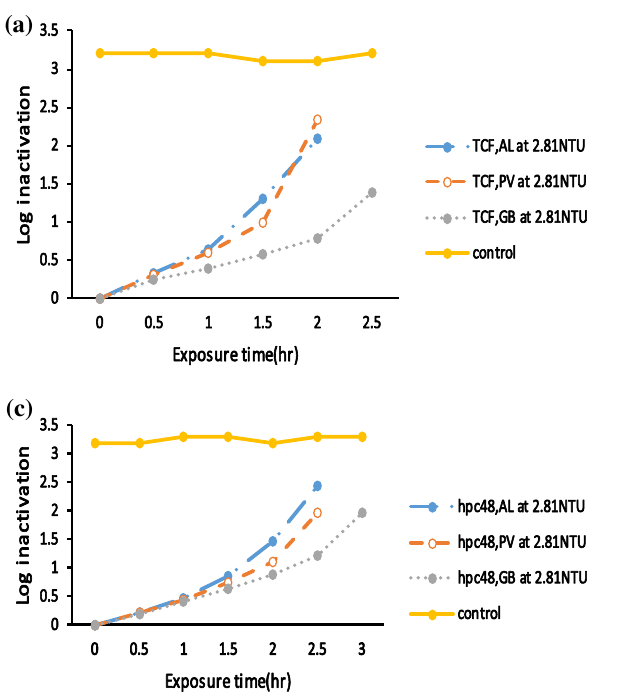
tors for E. coli inactivation. c Comparison between concentrators for heterotrophic plate count at 35 °C for 48-h